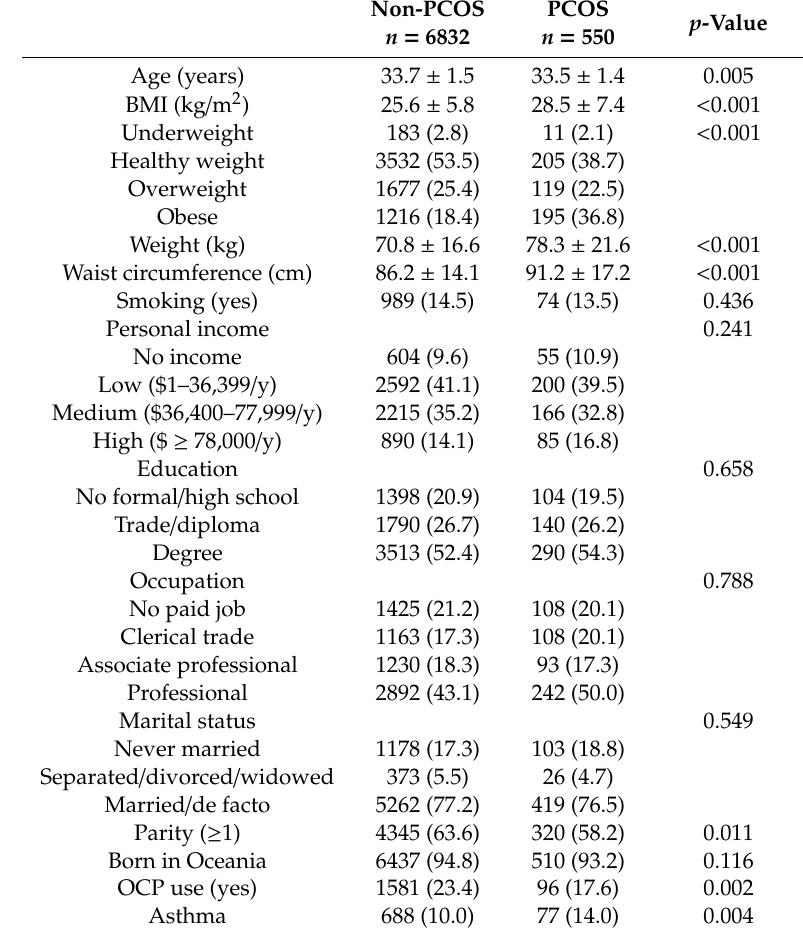
Table 1. Characteristics for women with and without polycystic ovary syndrome